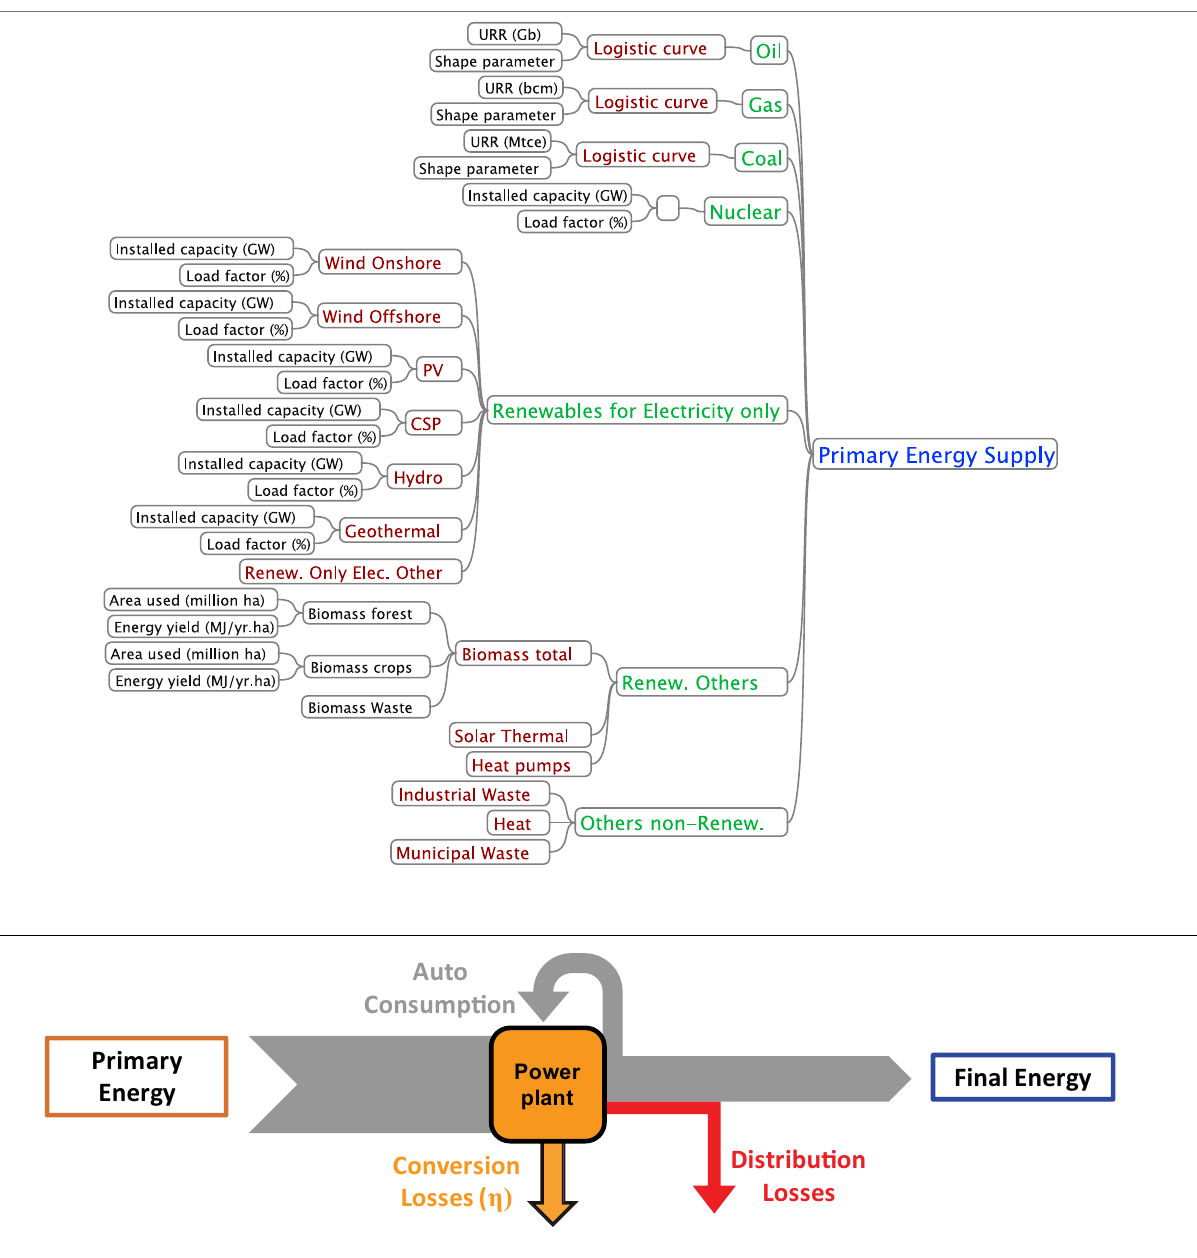
Table 3 |The primary energy breakdown and operationalization of variables in the supply module .